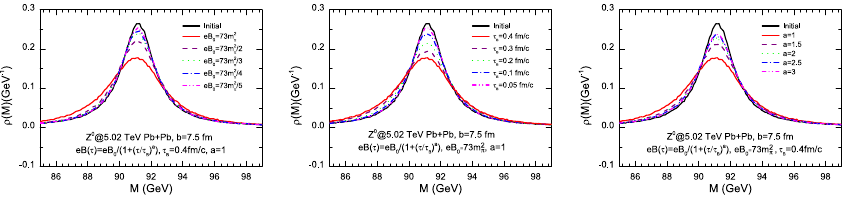
Figure 2. (Color online) The eB 0 , τ B and a dependences of Z 0 invariant mass distribution at midrapidity | ≤ 0 . 5 reconstructed by lepton pairs after interacting with e.m. fields. Left: eB | y z ; Middle: τ B varies from 0.05 fm / c to 0.4 fm / c ; Right: a varies from 1 to to 73 m 2 π